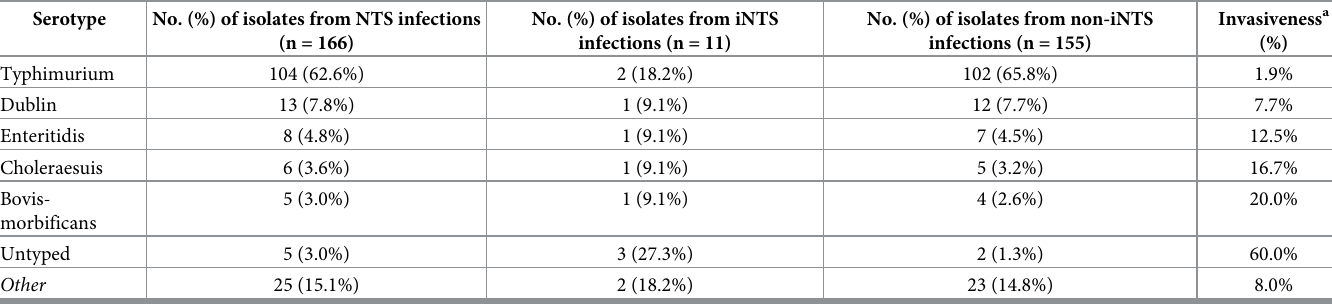
Table 1. Distribution of 166 NTS isolates by invasive or non-invasive infection status and serotype, Ningbo, China, 2012–2019.